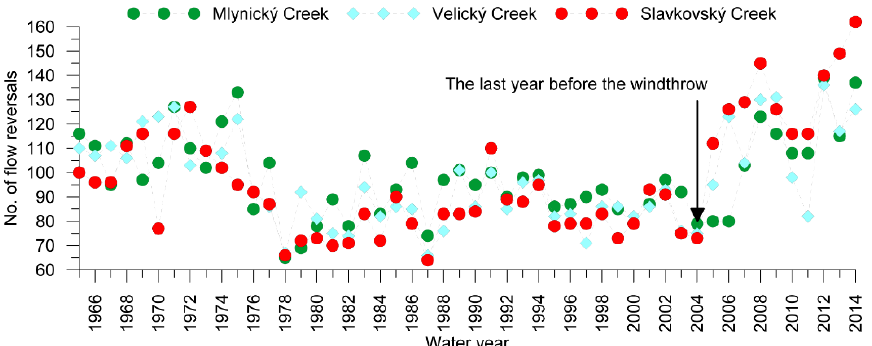
Figure 9. Number of flow reversals per year in the study catchments; the windthrow occurred at the beginning of the water year 2005.